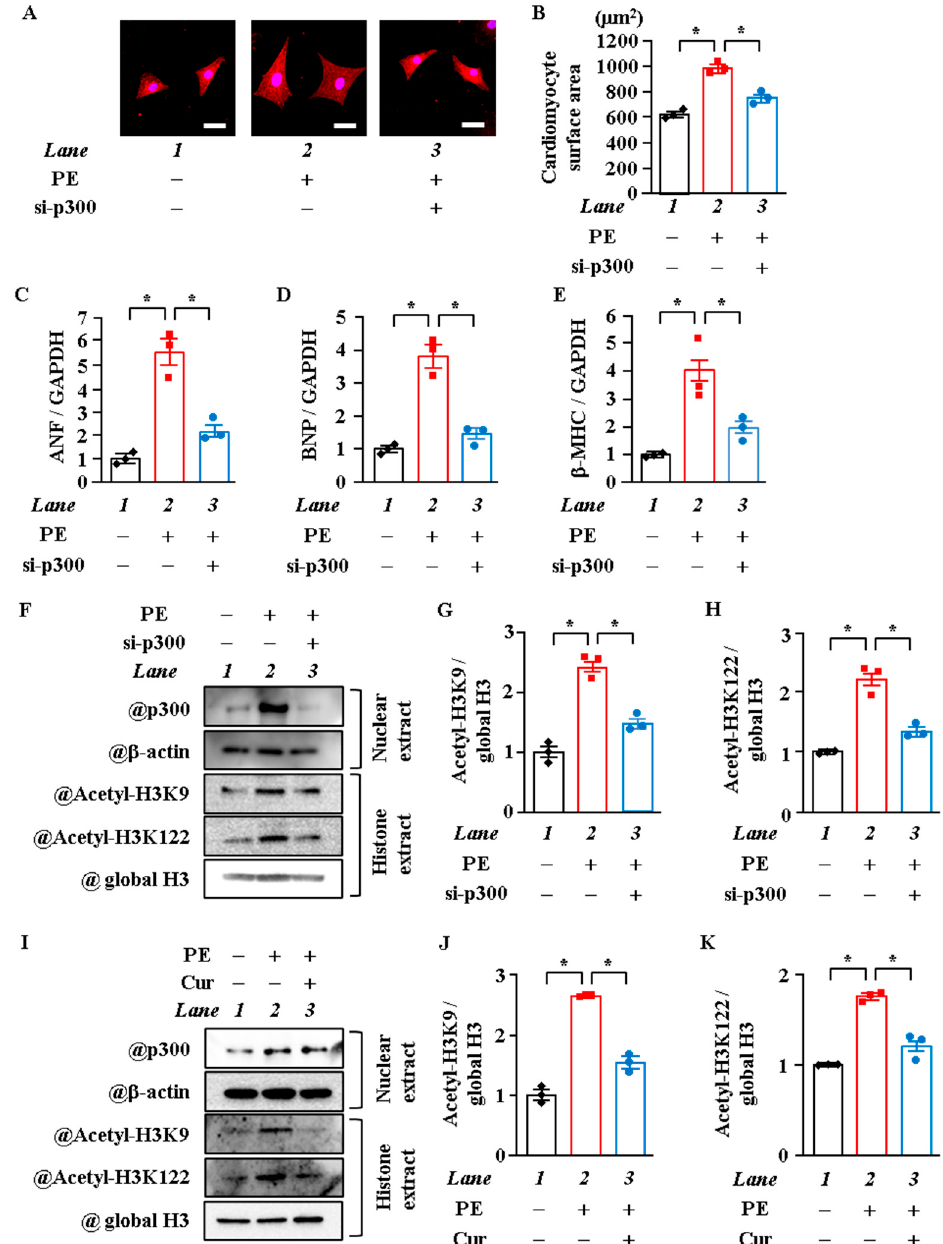
Figure 2. Knockdown of p300 and p300-HAT inhibitor suppressed histone acetylation. Primary cultured neonatal rat cardiomyocytes were transfected with p300 si-RNA or si-control as a control (50 nM, respectively). ( A and B ) Immunostaining was performed on primary cultured cardiomyocytes with anti-MHC antibody. The areas of 50 randomly chosen cells were measured using ImageJ v4.16. ( A ) is a photograph of representative cardiomyocytes, and ( B ) is a quantification of ( A ). Scale bar: 20 µ m. ( C – D ) mRNA was extracted from the cardiomyocytes, and mRNA levels of ANF ( C ), BNP ( D ), and β -MHC ( E ) were measured by qRT-PCR assay. ( F – H ) Nuclear proteins (nuclear extract) and histone fraction (histone extract) were extracted from the cardiomyocytes. ( F ) is a photograph of a representative Western blot, and ( G and H ) are quantifications of ( F ). ( I – K ) Primary cultured cardiomyocytes were treated with 10 µ M of curcumin (Cur), a p300 specific HAT inhibitor, and were stimulated with 30 µ M of PE. Nuclear proteins and histone fraction were extracted from primary cardiomyocytes after 48 h of PE stimulation. (I) is a photograph of a representative Western blot, and ( J ) and ( K ) are quantifications of ( I ). ( B – E , G , H , J , and K ), N = 3; one-way ANOVA followed by Tukey test. * p < 0.05.